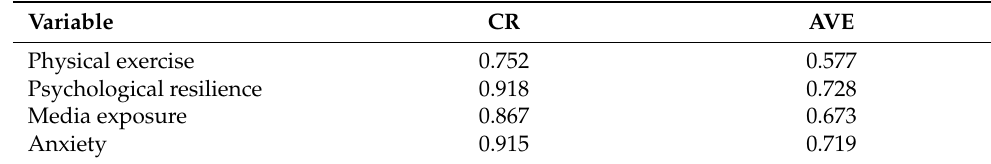
Table 2. Confirmatory factor